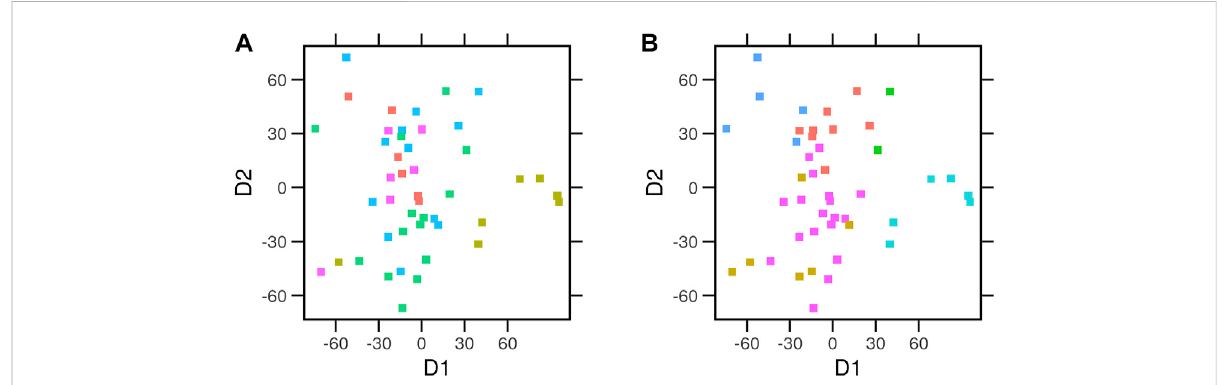
FIGURE 4 Multidimensional scaling of the average expression pro fi les of cancer cell lines. Gene expression for the control condition of the library of integrated network-based cellular signatures (LINCS) cell lines ( N = 46) data was used in multidimensional scaling (MDS). Euclidean distances between the expression pro fi les were calculated. The relative position of the cell lines across the fi rst two dimensions (D1 and D2) is laid out. Each point represents a cell type. Cells were colored by the different (A) tissue of origin or (B) the assigned